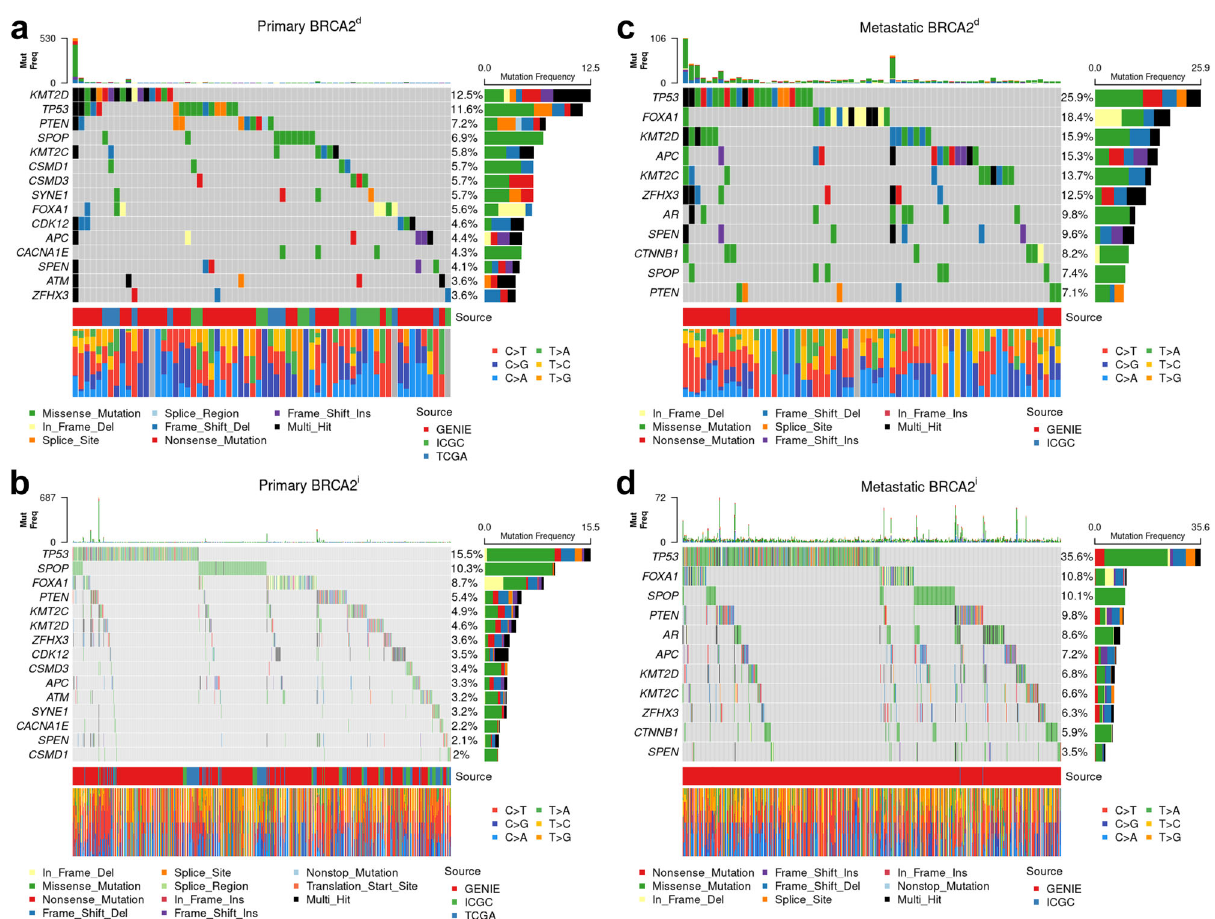
Fig. 3 Oncoplots of pathogenic single nucleotide variants among primary and metastatic BRCA2 -de fi cient and BRCA2 -intact tumors. Plots correspond to ( a ) primary BRCA2 -de fi cient tumors, ( b ) primary BRCA2 -intact tumors, c metastatic BRCA2 -de fi cient tumors, and d metastatic BRCA2 -intact tumors. Figures display the most frequently altered candidate genes (Table 1), as was the frequency of TMPRSS2 - ERG fusions (28.4% vs 29.9%, p-0.62). Similarly, no differences in the frequency of TMPRSS2-ETV1, TMPRSS2- intragenic, or other SVs involving ETS genes were observed between BRCA2 d and BRCA2 i primary tumors. In metastatic tumors, TMPRSS2 - ETV1 fusions were more common among BRCA2 d (3.0%) than BRCA2 i tumors (0.1%; p = 0.017). In metastatic tumors, the prevalence of TMPRSS2 -ETS fusions did not differ by tumor BRCA2 status, nor did the prevalence of TMPRSS2-ERG, TMPRSS2- intragenic or other SVs involving ETS family genes.